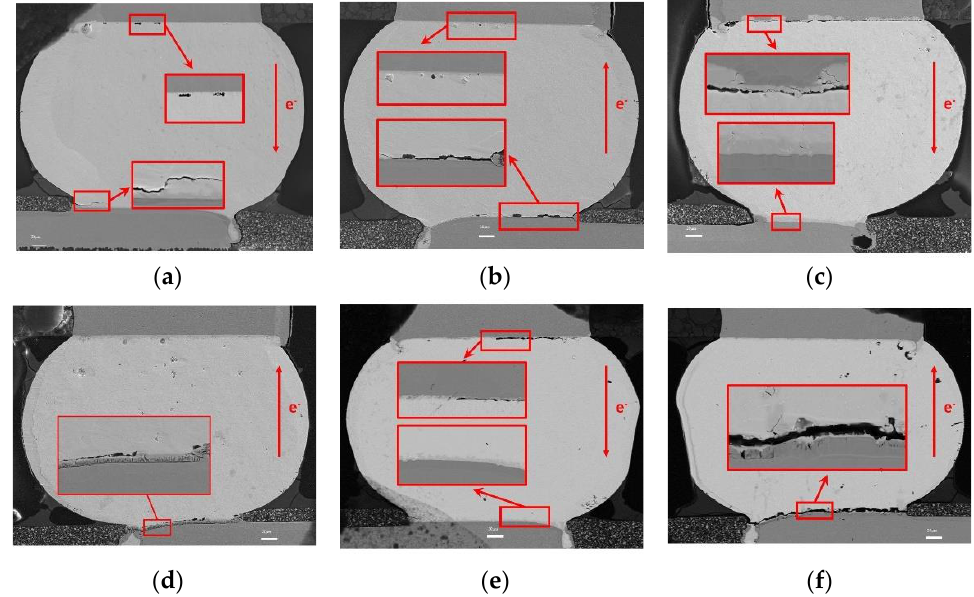
Figure 5. Interfacial failure modes of three samples. ( a ) Sample 1#L, ( b ) Sample 1#R, ( c ) Sample 2#L, ( d ) Sample 2#R, ( e ) Sample 3#L, ( f ) Sample 3#R.